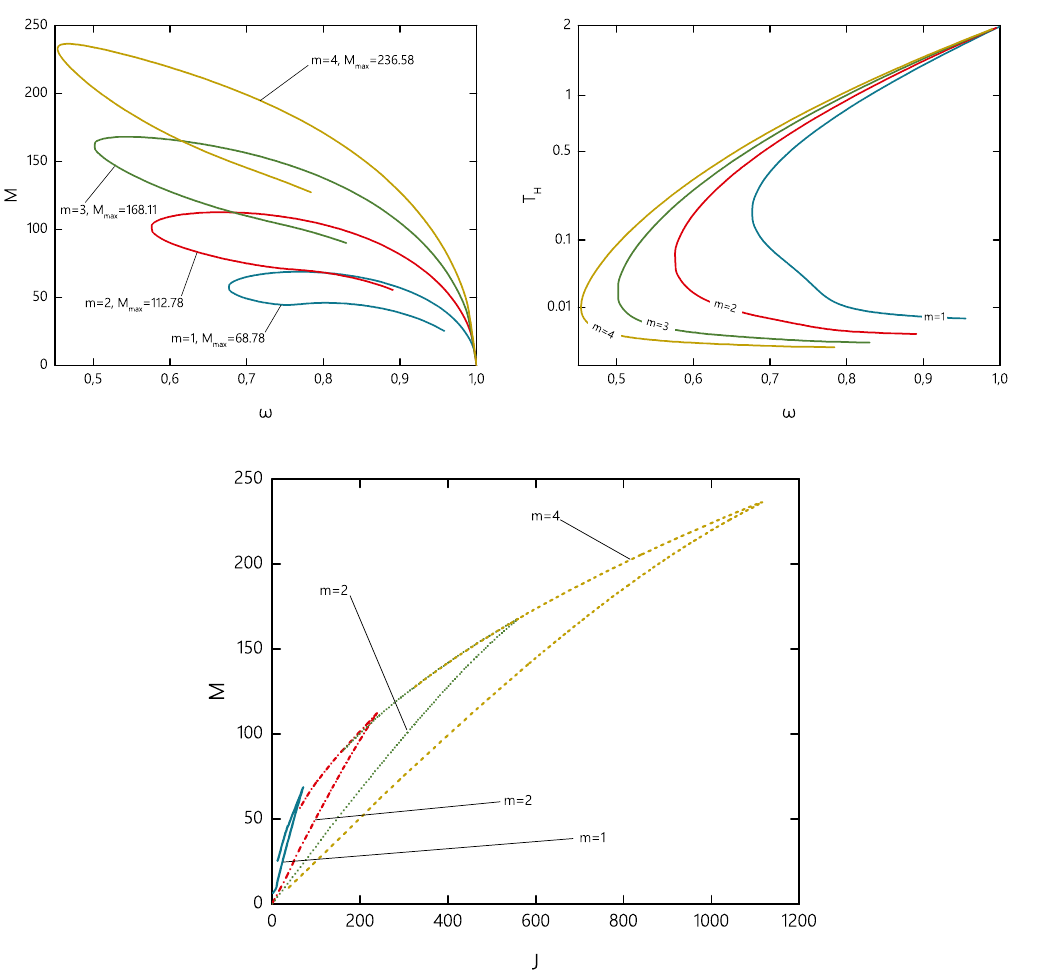
Figure 6 . ADM mass M (upper left panel) and Hawking temperature T H (upper right panel) as functions of the angular frequency ! . Scaled ADM mass vs. total angular momentum J (bottom panel) for a set of values of the winding number m for rotating hairy BHs with r h = 0 : 01 ; (cid:11) = 0 :